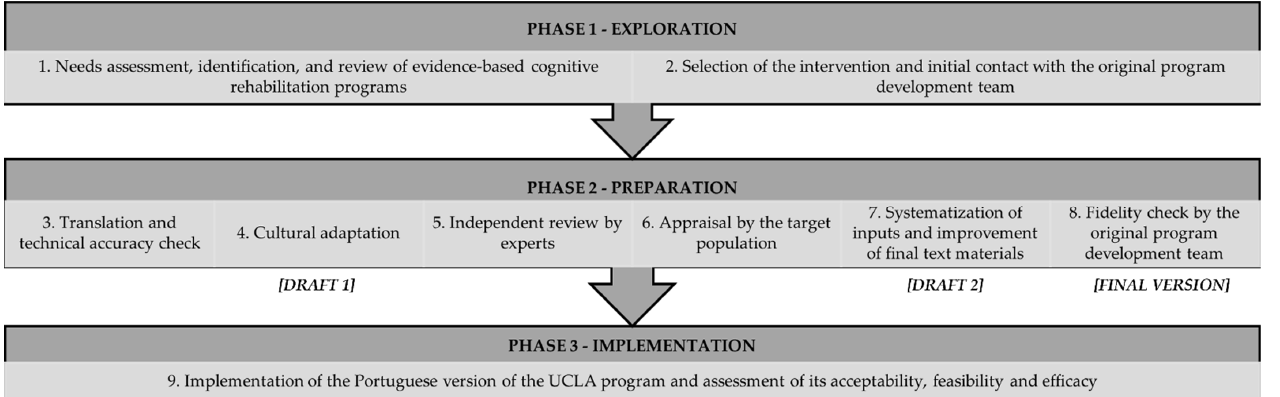
Figure 2. Framework for the cultural adaptation process of the UCLA Cognitive Rehabilitation Intervention Program to Portugal.